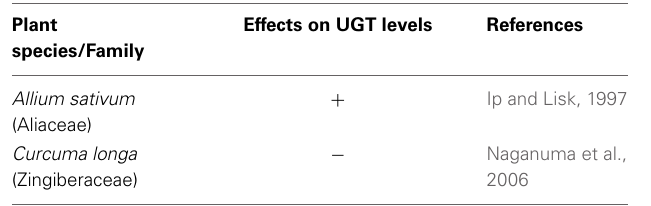
Table 8 | Medicinal plant species listed in RENISUS with reported effects of on UGT levels.